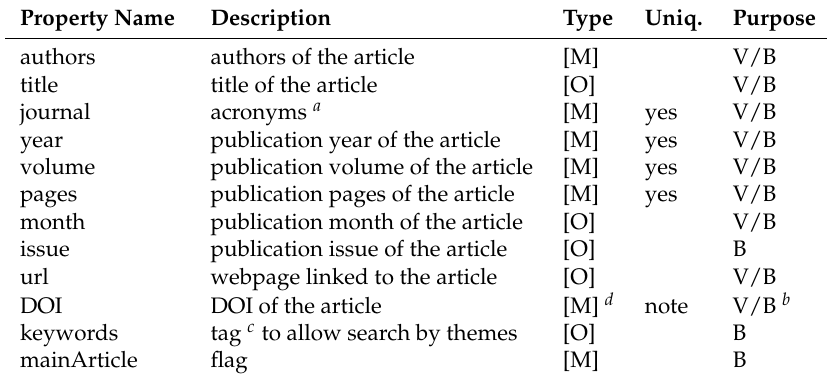
Table 6. List of properties/metadata for the object “Publications”. The symbols [M] and [O] indicate that the metadata are either mandatory or optional in the import file. In the column “Uniq.”, we indicate whether the metadata define the uniqueness of the object. In the column “Purpose”, we indicate whether the information is meant for the BASECOL (B) public WebUI display and/or for VAMDC (V)